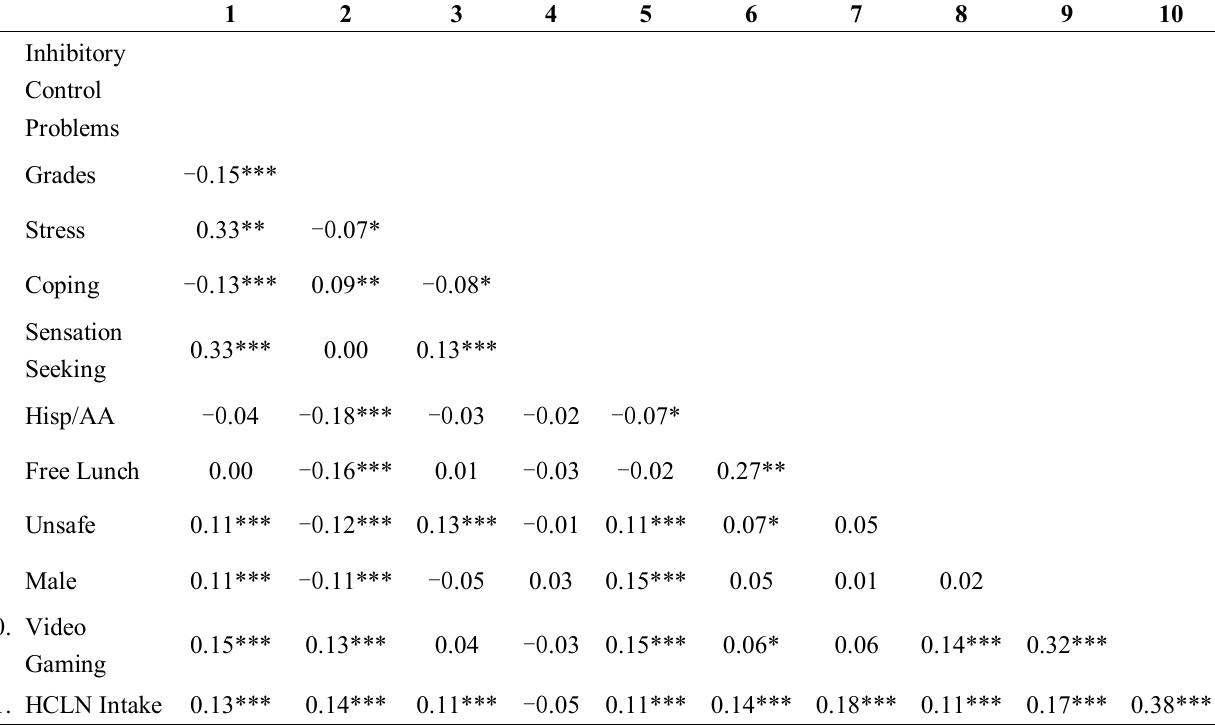
Table 2. Bivariate correlations among study